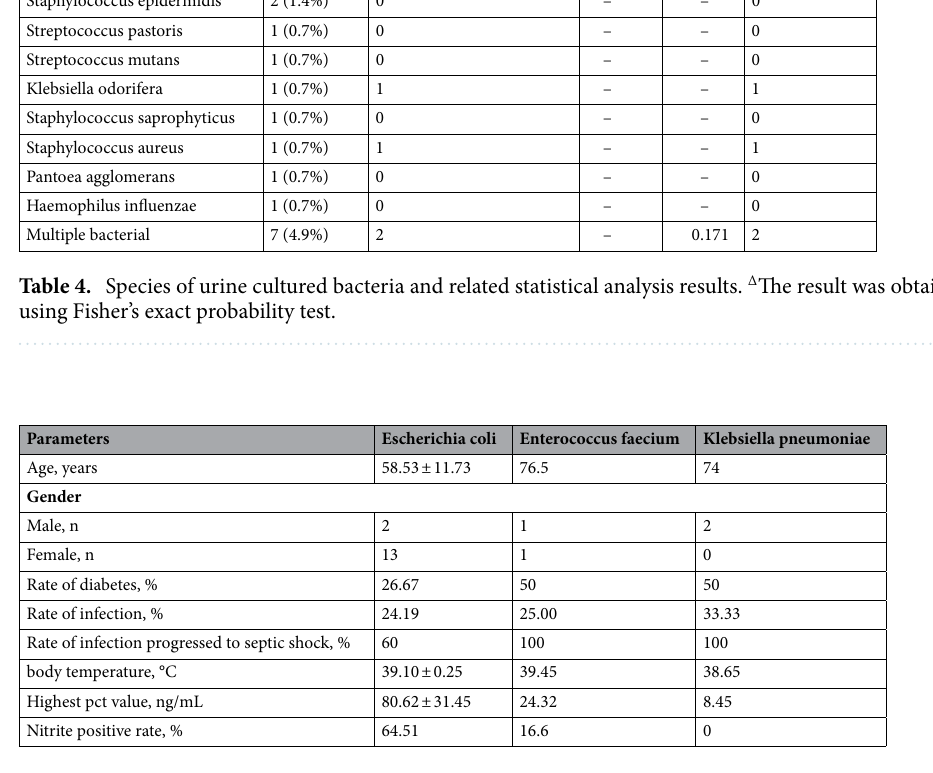
Table 5. The clinical characteristics of post-PCNL infection caused by different bacteria.